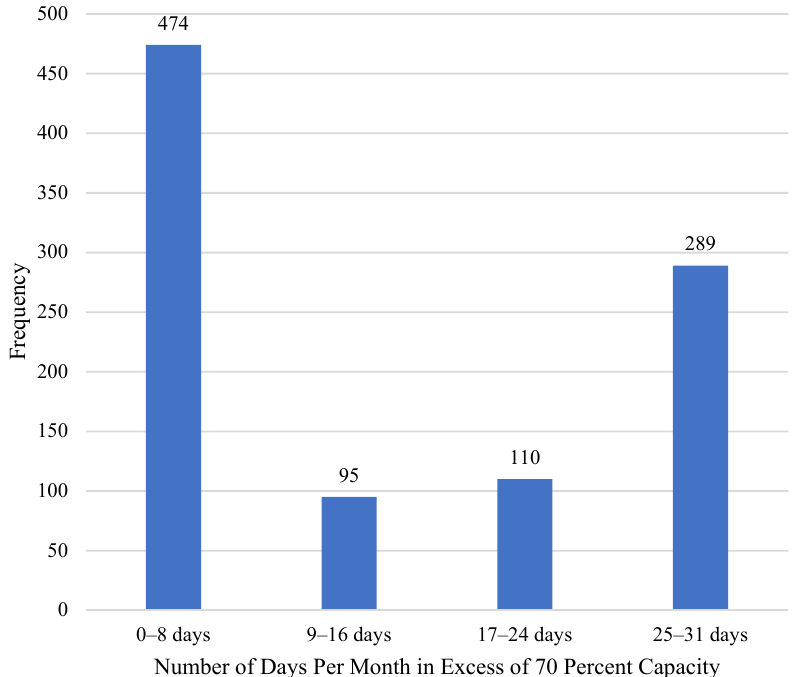
Figure 5. Frequency of Days per Month in Excess of 70 Percent Capacity. Source: (COVID-19 Reported Patient Impact and Hospital Capacity by State Timeseries 2021).